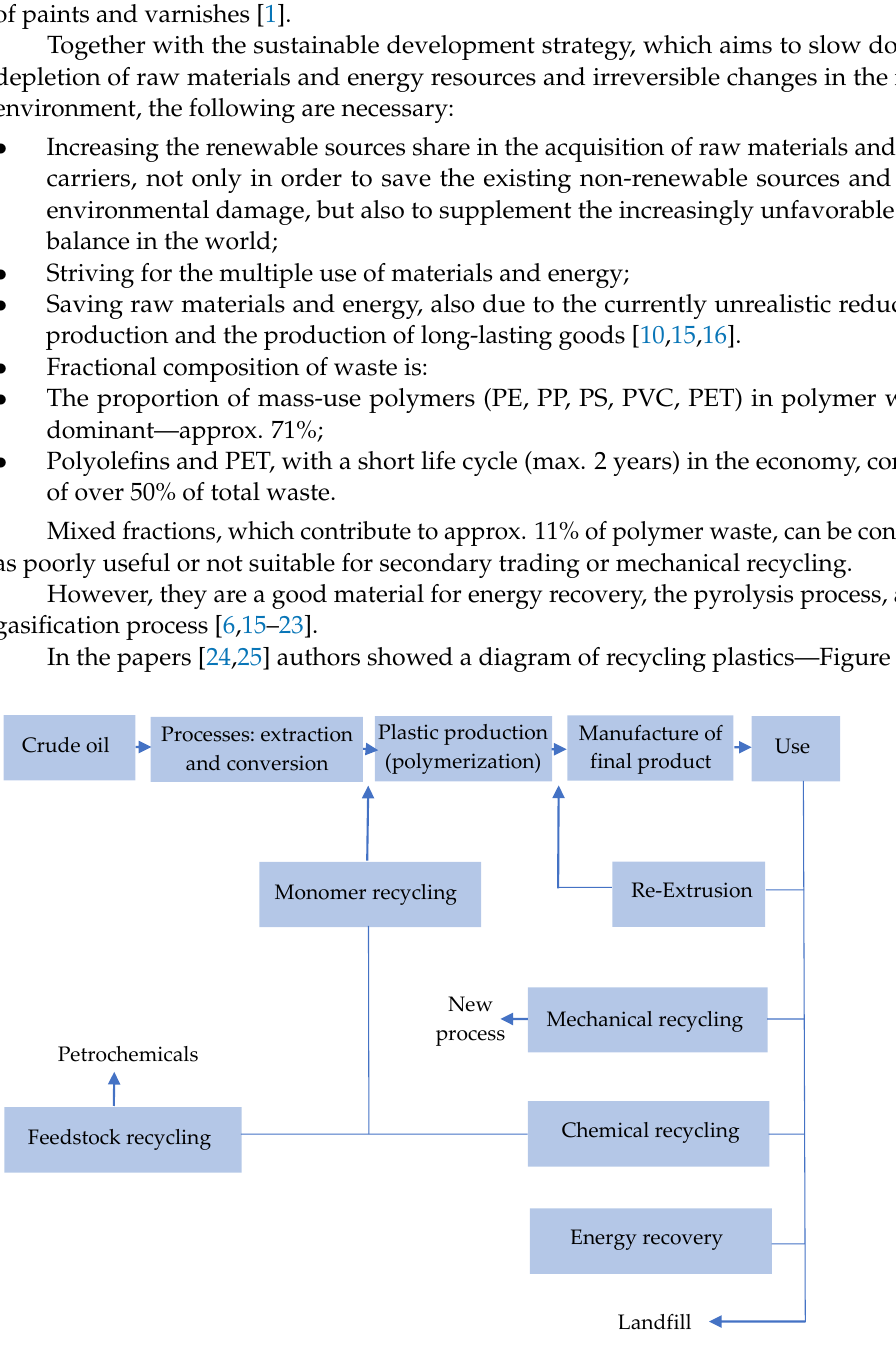
Figure 12. Schematic of recycling methods. Made based on [24,25]. The choice of the recycling plastics optimal method depends on contamination degree of the material and the size of the waste